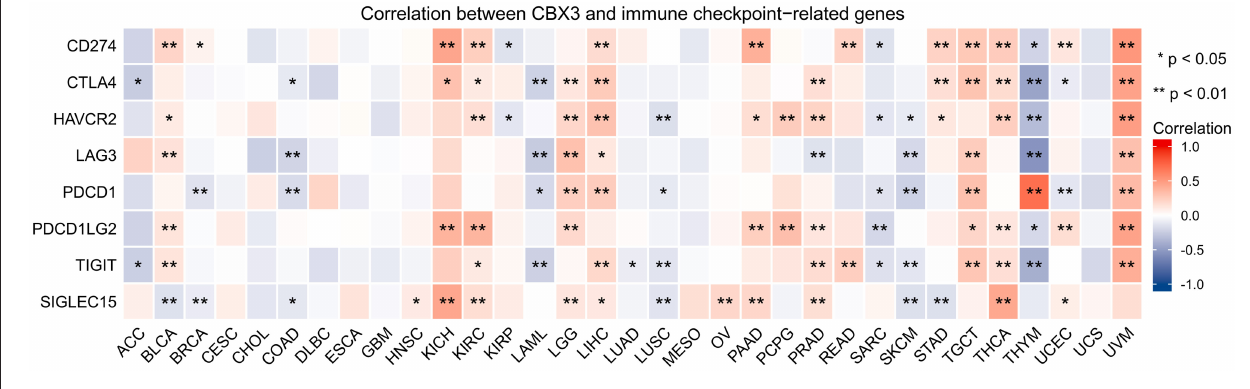
FIGURE 10 | Correlation between the expression of CBX3 and immune checkpoint related genes. * P < 0.05, ** P <